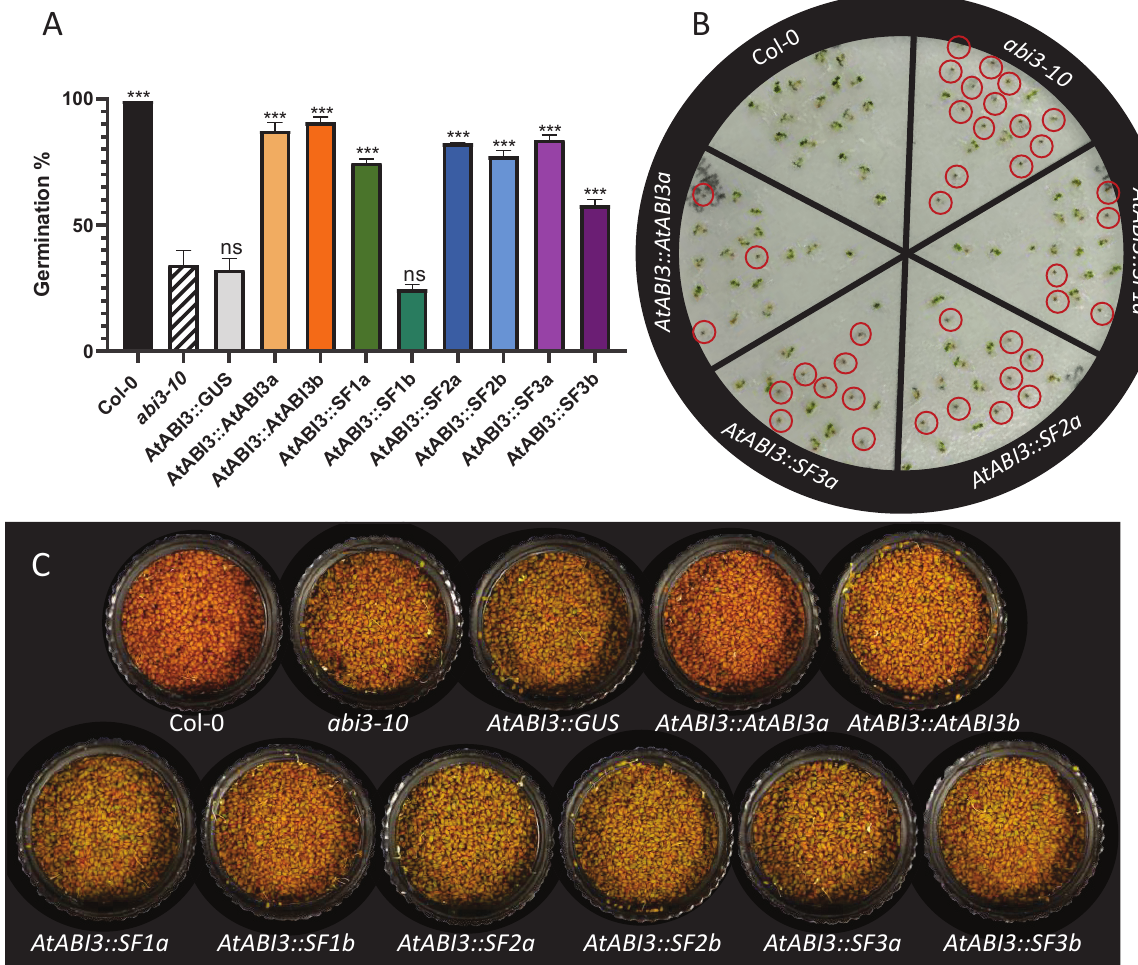
Figure 4. Complementation of Arabidopsis abi3-10 mutant with M. truncatula ABI3 isoforms. ( A ) Germination percentage of mature seeds from wild-type background (Col-0), Atabi3-10 mutant, empty vector ( AtABI3::GUS ), and complemented lines with Arabidopsis full-length transcript ( AtABI3::AtABI3 ). Three technical replicates of 100 seeds each were used. One-way ANOVA showed that all genotypes were significantly different from the Arabidopsis abi3 mutant, with the exception of the empty plasmid ( AtABI3::GUS ) and line containing AtABI3::SF1b . ‘ns‘ indicates a nonsignificant difference and ***: p ≤ 0.001. ( B ) Illustration of germination test showing Col-0, abi3-10 , AtABI3 complementation, and M. truncatula ABI3 isoform complementation. Red circles indicate non-germinated seeds ( C ) Mature and dried seed colors. Controls genotypes are shown in the upper panel, and M. truncatula ABI3 isoform complemented lines are shown in the lower